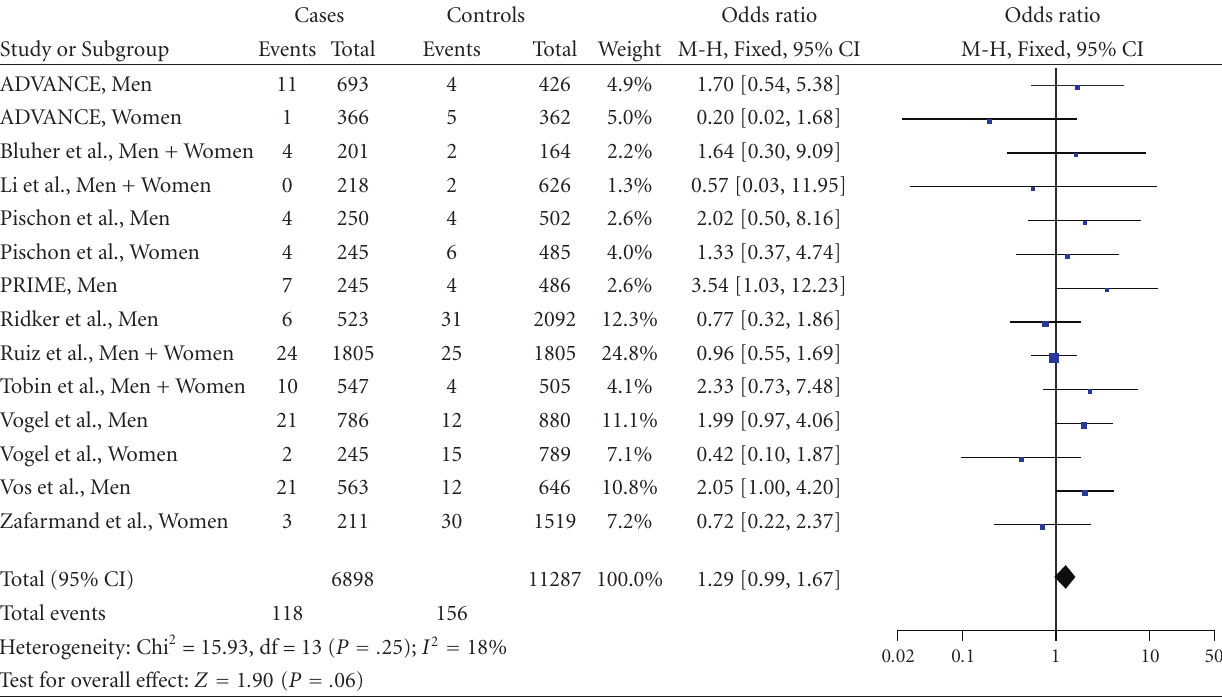
Heterogeneity: Chi 2 = 15.93, df = 13 ( P = . 25); I 2 = 18% Test for overall e ff ect: Z = 1 . 90 ( P = .